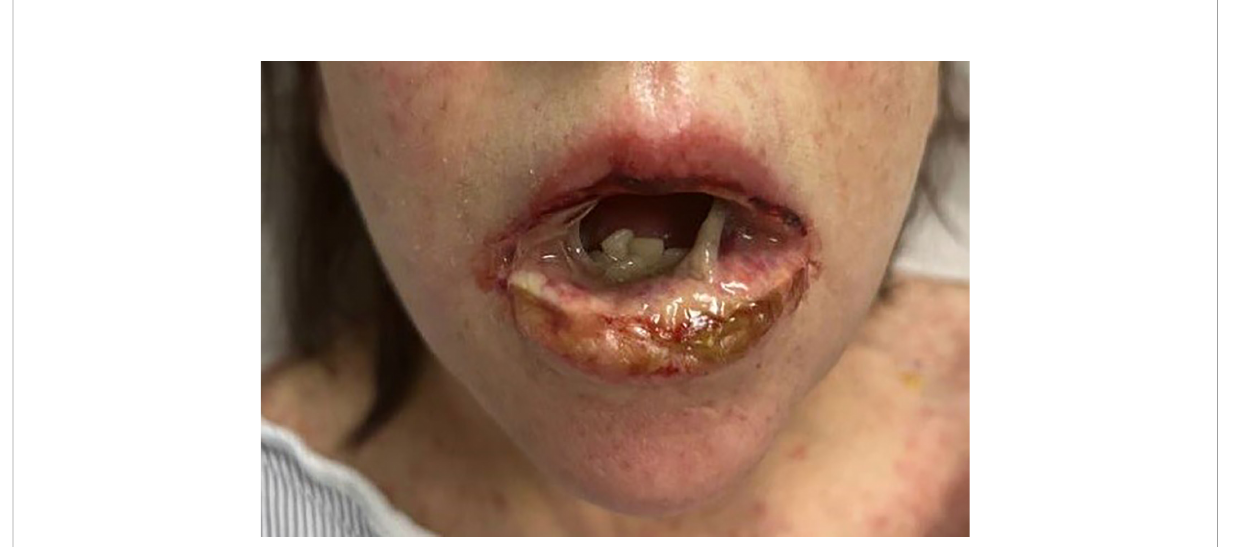
FIGURE 3 morbiliform rash Exudative and hemorrhagic sloughing of the lips and buccal